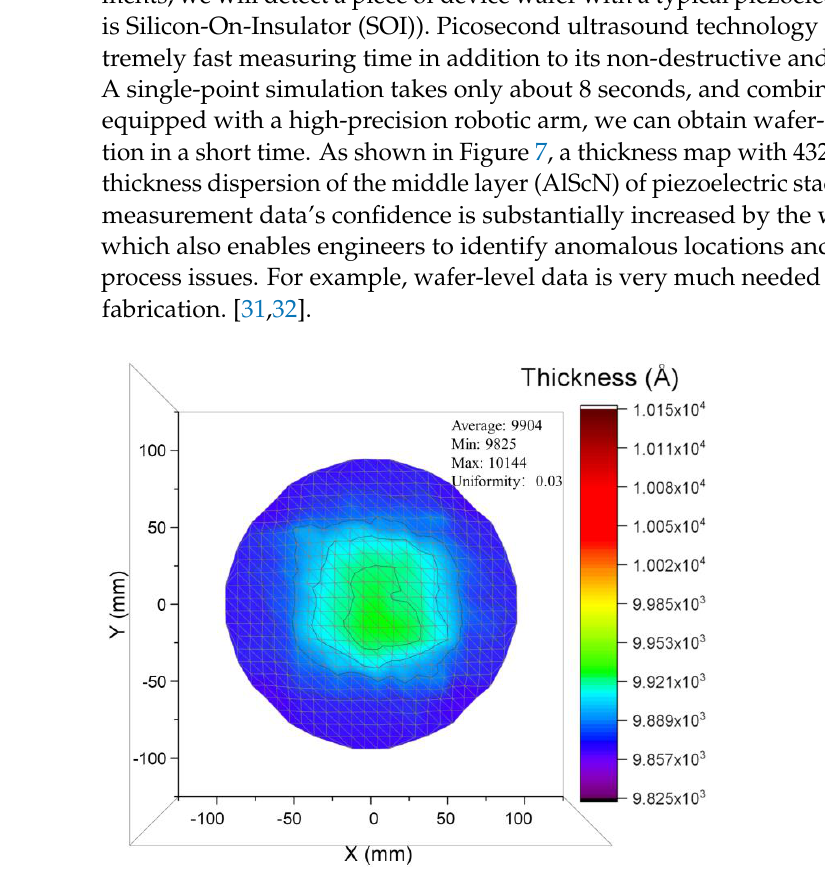
Figure 7. A thickness map with 432 points representing the thickness dispersion of the middle layer (AlScN) of device wafer.